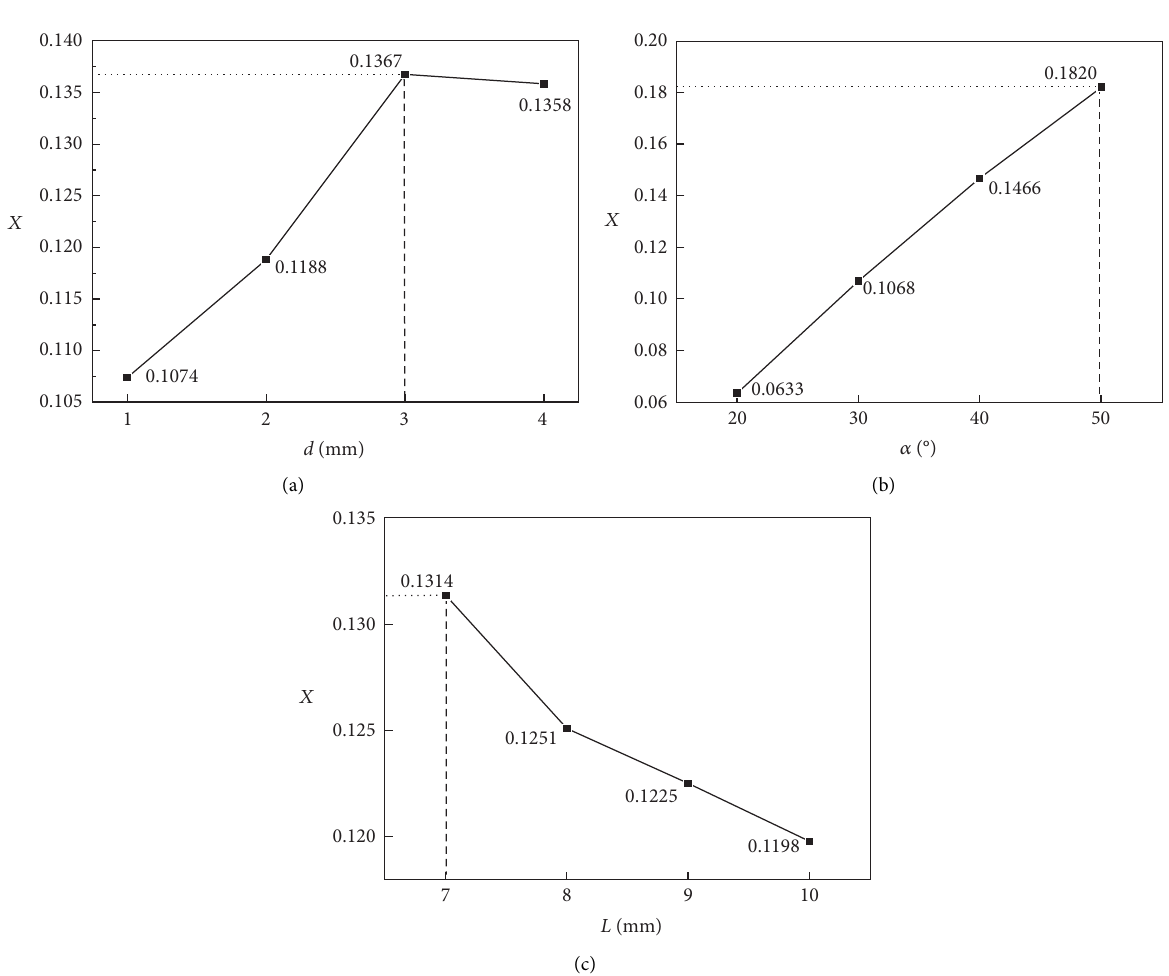
Figure 11: The change curve of the X -value under the single